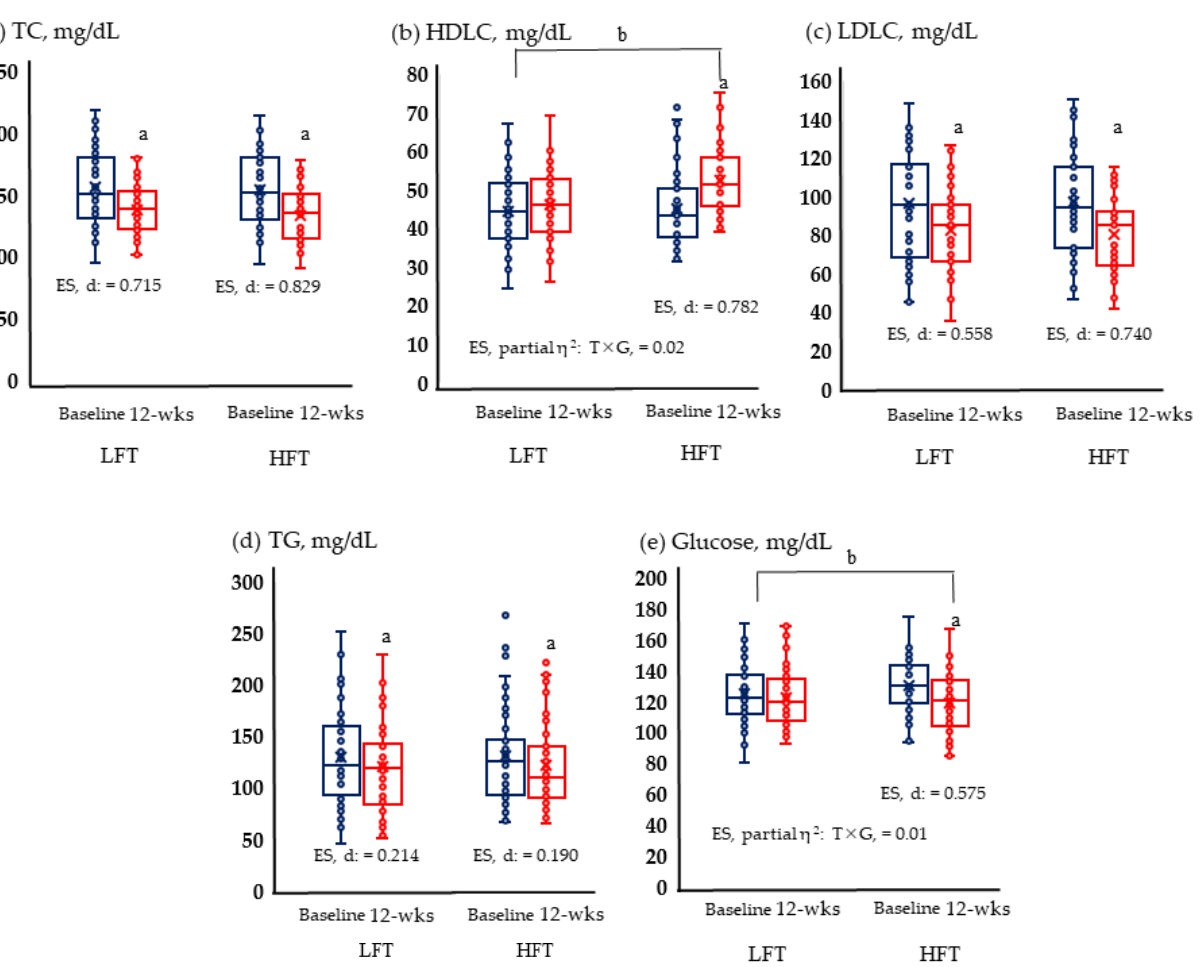
Figure 1. Lipid and glucose metabolism are risk factors for cardiovascular disease; ( a ) Change of TC; ( b ) change of HDLC; ( c ) change of LDLC; ( d ) change of TG; and ( e ) change of glucose in LFT and HFT groups according to 12 weeks intervention. p < 0.05; a, Baseline vs. 12 wks; b, time × group; wks, weeks; LFT, low-frequency training; HFT, high-frequency training; ES, effect size; T × G, time × group. TC, total cholesterol; HDLC, high-density lipoprotein cholesterol; LDLC, low-density lipoprotein cholesterol; TG, triglycerides. Blue boxplots are baselines corresponding to pre-intervention, and red boxplots are 12-wks post-interventions.